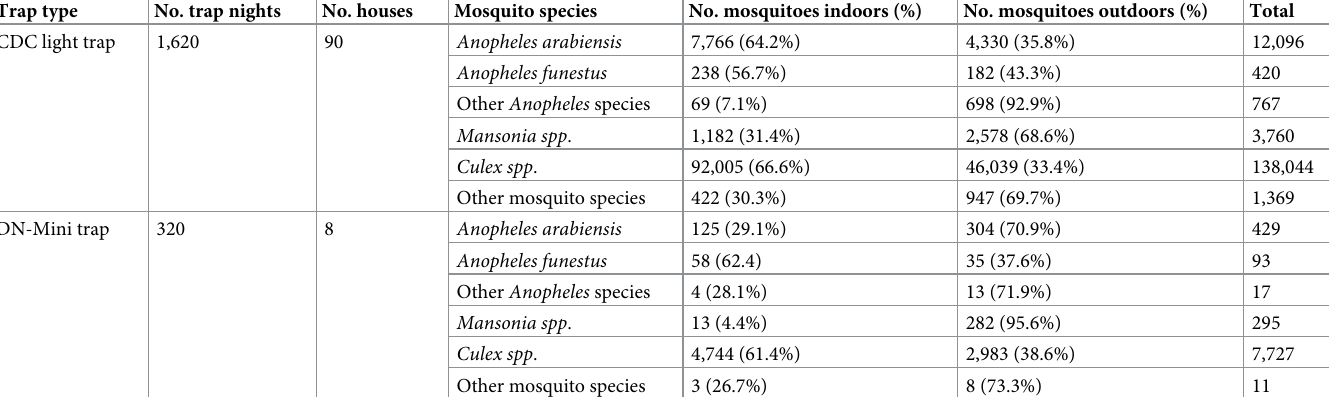
Table 3. Number of mosquitoes of different species collected indoors and outdoors using CDC-light traps or miniaturized double net traps (DN-Mini) in the study